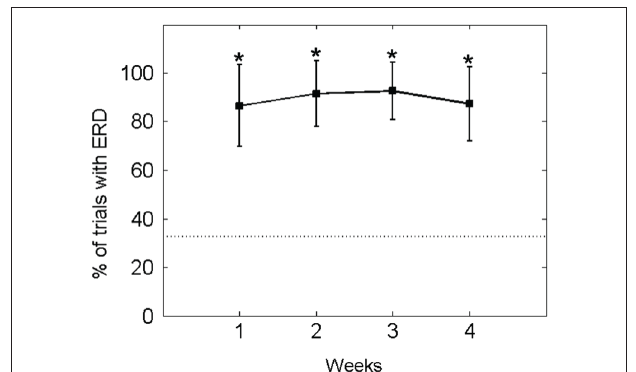
FIGURE 6 | Percentage of EcoG trials with orthosis movement (i.e., event-related desynchronisation [ERD] in the beta-band): The mean ± standard deviation of the performance measure per week is indicated by solid lines . The mean of the baseline data is indicated as a dotted line. An asterisk (*) marks weeks in which the mean of the performance measure differs significantly ( p < 0.05) from the mean of the baseline